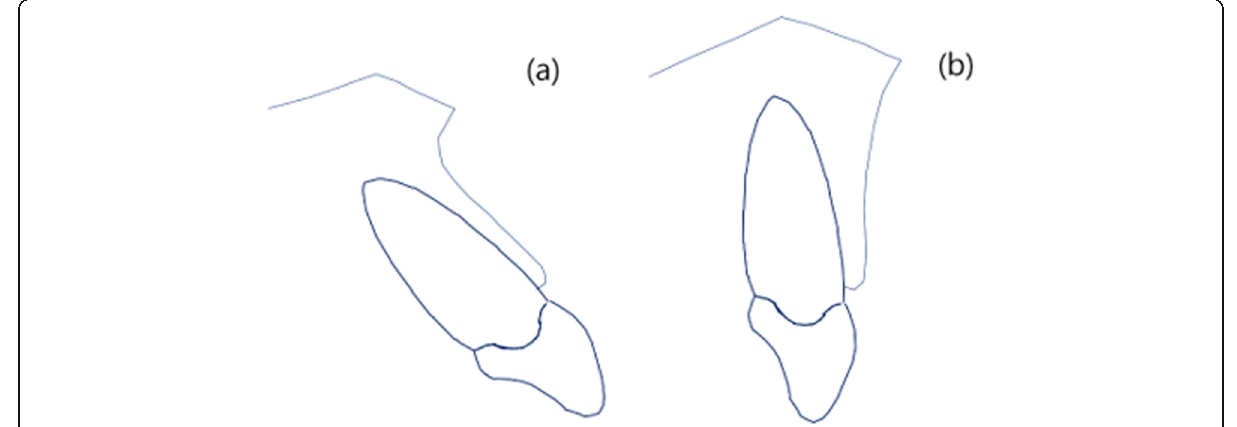
Fig. 7 The condition describes alveolar bone architecture tends a to follow as the incisors retracted b not to be remodeled as expected in Fig.